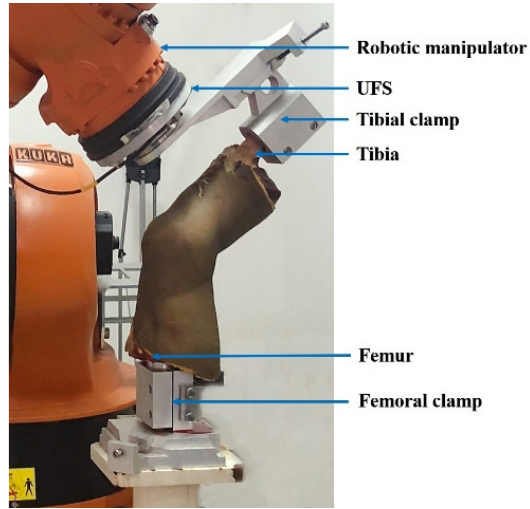
Figure 1. Human cadaveric knee model tested with robotic universal force/moment sensor (UFS) testing system.